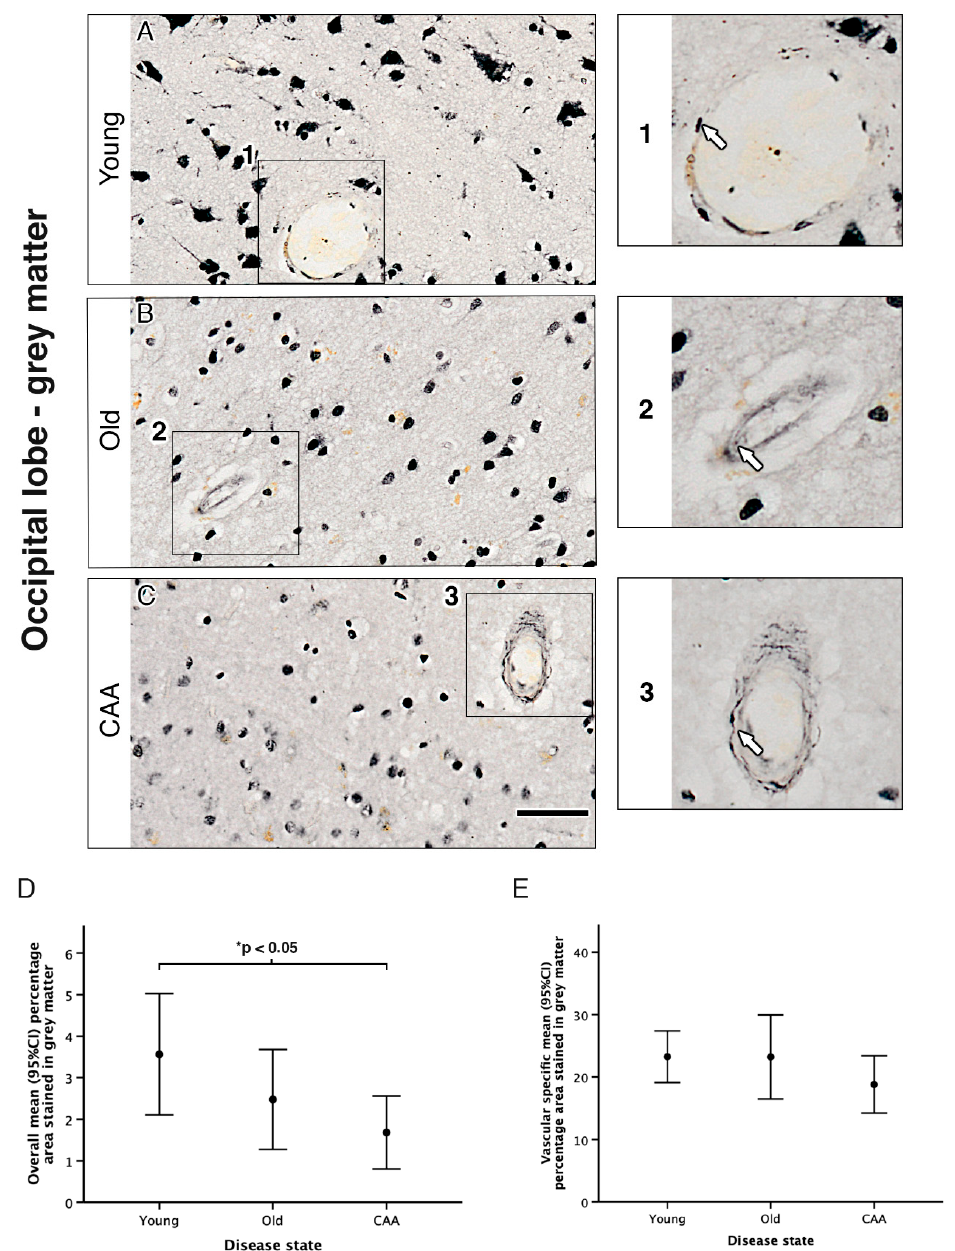
Figure 1. The pattern of distribution of the α -adrenoceptors alpha1a adrenergic receptor ( α 1A -AR) in the grey matter of the occipital lobe. Neuronal staining appeared most intense in young cases ( A ) and decreased in both old ( B ) and cerebral amyloid angiopathy (CAA) cases ( C ). In all cases, α 1A -AR immunoreactivity was observed in vessel walls (enlarged boxes 1, 2 and 3). There was a significant decrease in α 1A -AR in CAA cases compared to young groups ( D ) and no differences observed in the vessel wall ( E ). Graphs depict the mean ±95% confidence intervals; n = 5. Scale bar 50 µm. * p < 0.05.